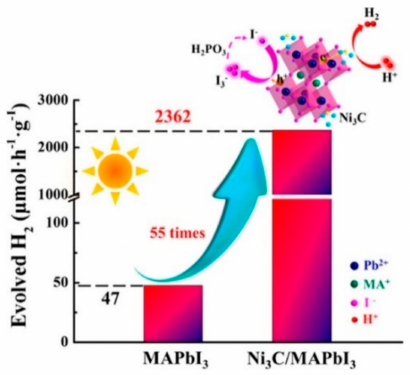
Figure 19. Comparison of H 2 evolution in aqueous HI solutions containing MAPbI 3 and Ni 3 C decorated MAPbI 3 . Reprinted with permission from [322], Copyright (2019) American Chemical Society.